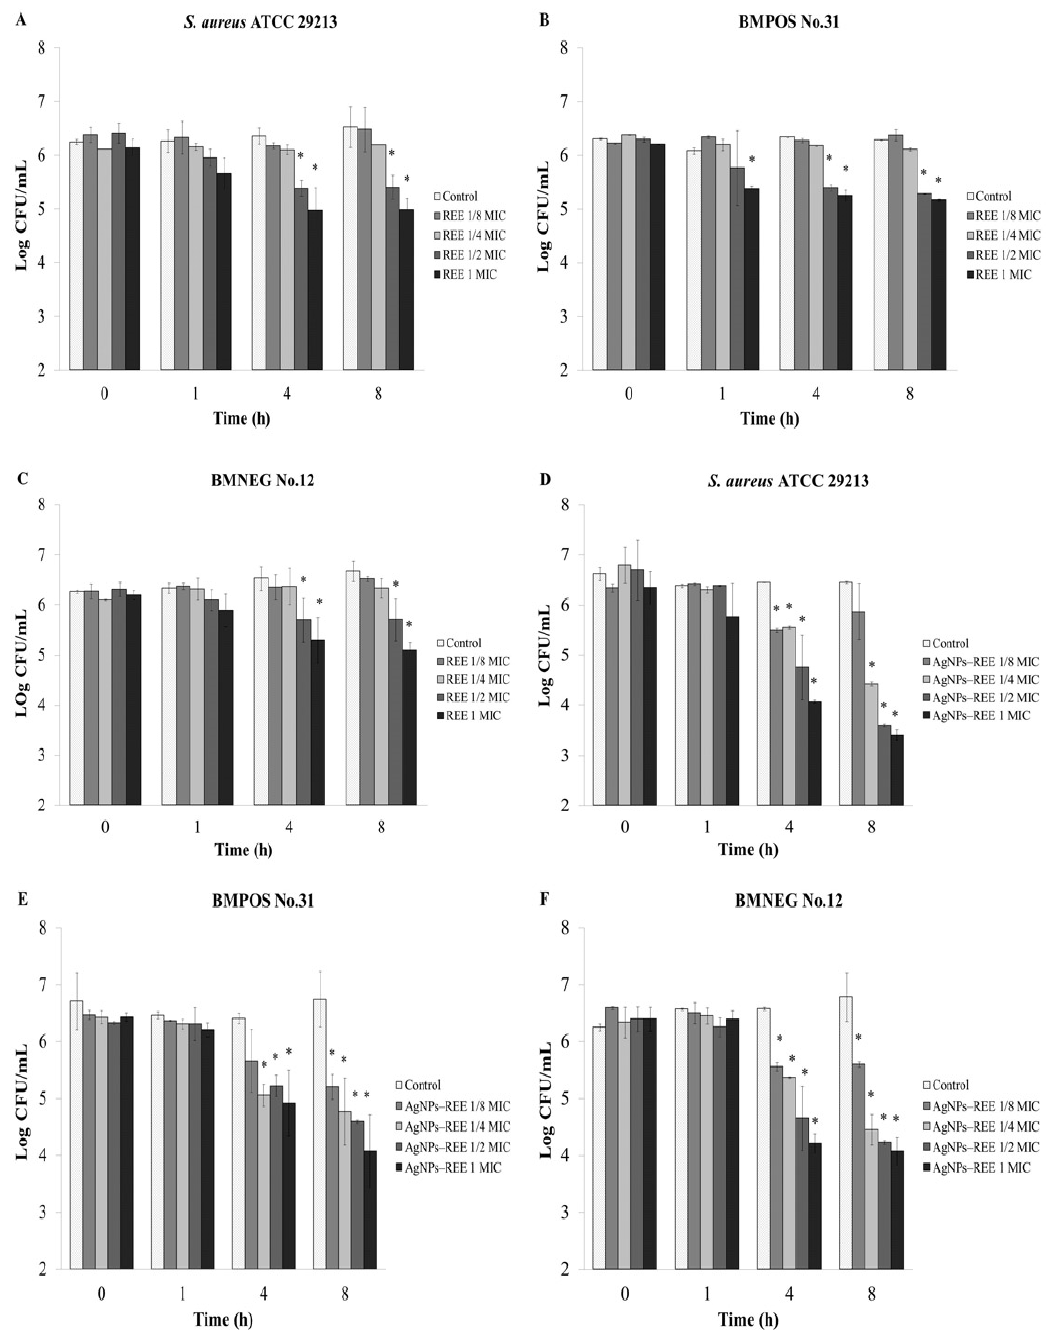
Figure 2. Quantification of bacterial adherence by ex vivo anti-adhesion assay. Each bar represents the number of adherent bacteria to bovine udder tissue evaluated by viable plate count. Bacterial isolates were treated with 1/8 ×minimum inhibitory concentration (MIC), 1/4 × MIC, 1/2 × MIC, and 1 × MIC of the ethanolic extract; R. tomentosa ethanolic extract (REE) ( A – C ) or synthesized AgNPs with capped REE (AgNPs–REE) from the ethanolic extract ( D – F ) at various time points (h). 1% DMSO was used as a control. The data represent the pooled results from a least two experiments and are expressed as a mean value ± standard deviation (SD). * p < 0.05, compared to the control.